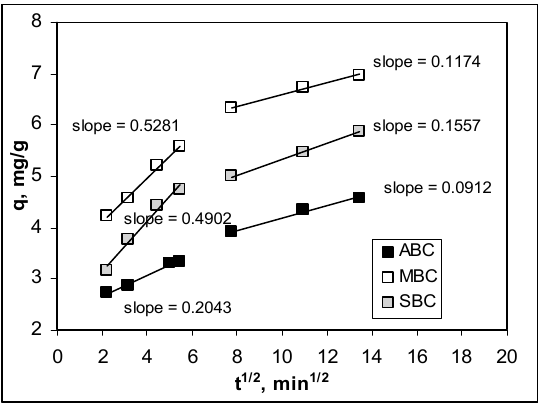
Figure 7. Linear representations of intra-particle diffusion model for retention of Co(II) ions on ABC, MBC, and SBC.